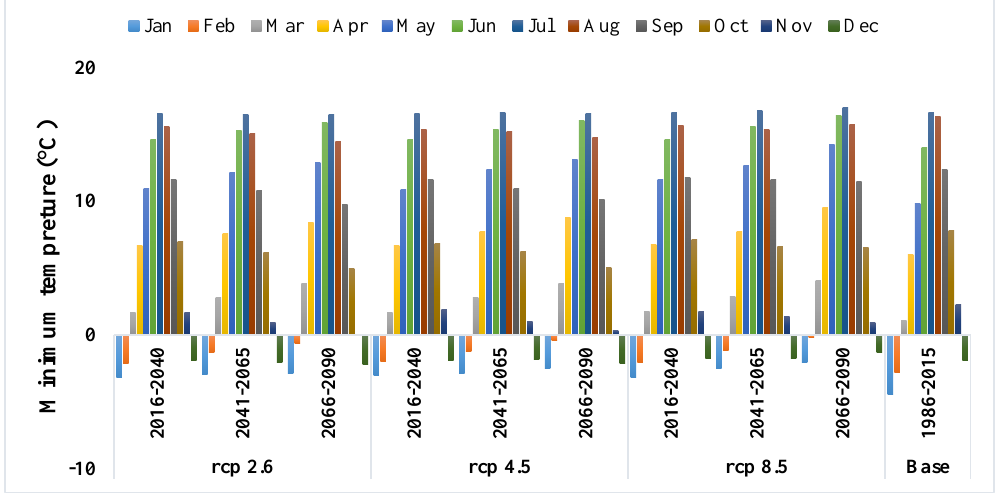
Figure 2. Comparison of the mean monthly minimum temperature of periods 2016–2040, 2041–2065, and 2066–2090 under scenarios rcp2.6, rcp4.5, and rcp8.5 with the baseline period.